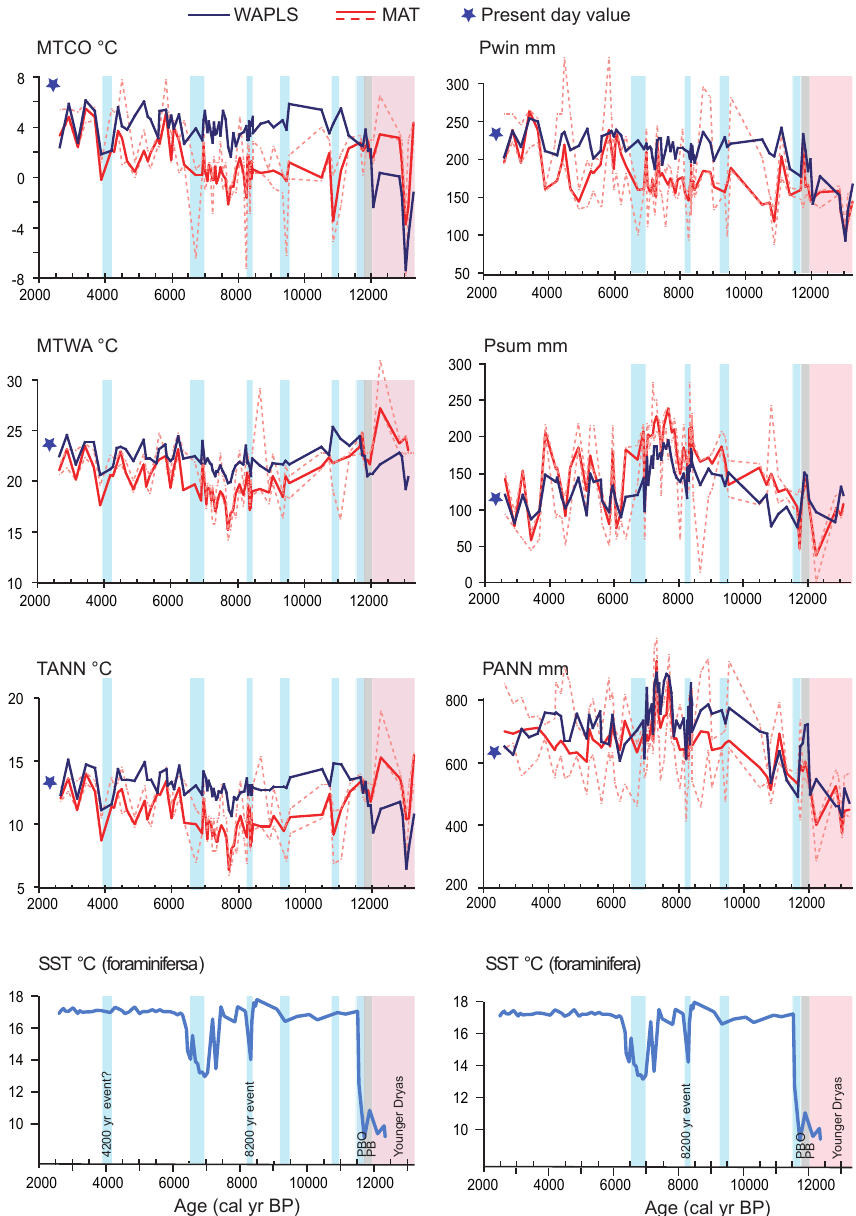
Fig. 3. Quantitative climate reconstructions from pollen analyses obtained by the MAT (red: dotted line corresponds to error) and WAPLS (blue) methods. Present-day values for temperature (MTCO, MTWA and TANN) and precipitation (Pwin, Psum and PANN) are represented by blue stars. SSTs (blue) from the same core are reported at the base of the figure for comparison with the pollen inferred reconstruction. All curves are presented in cal yr BP. Colored bars underline climate events: YD (pink), PB (grey), PBO and Holocene events